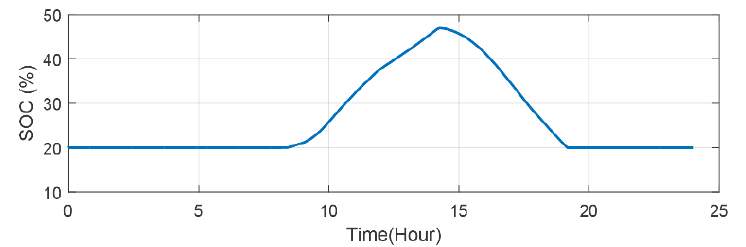
Figure 16. State of Charge (SOC) of BES of during the day hours.